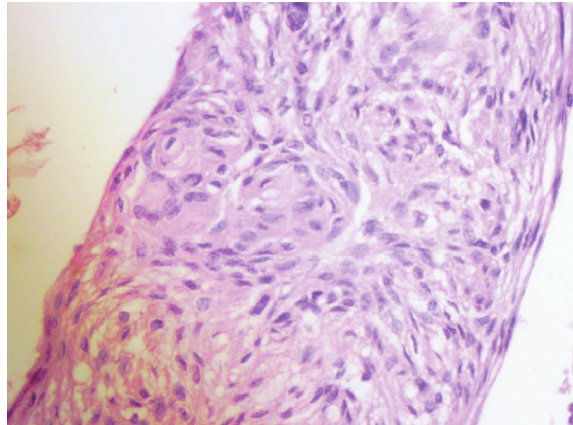
Figure 4: Neoplasia consisting of masses of elongated cells with imprecise limits, finely granular cytoplasm, and large rounded or oval nuclei; cytoplasmic invaginations configuring nuclear pseu- doinclusions are visible at the top left, and the cells are arranged in lobes separated by fibrous tissue with some vorticilar